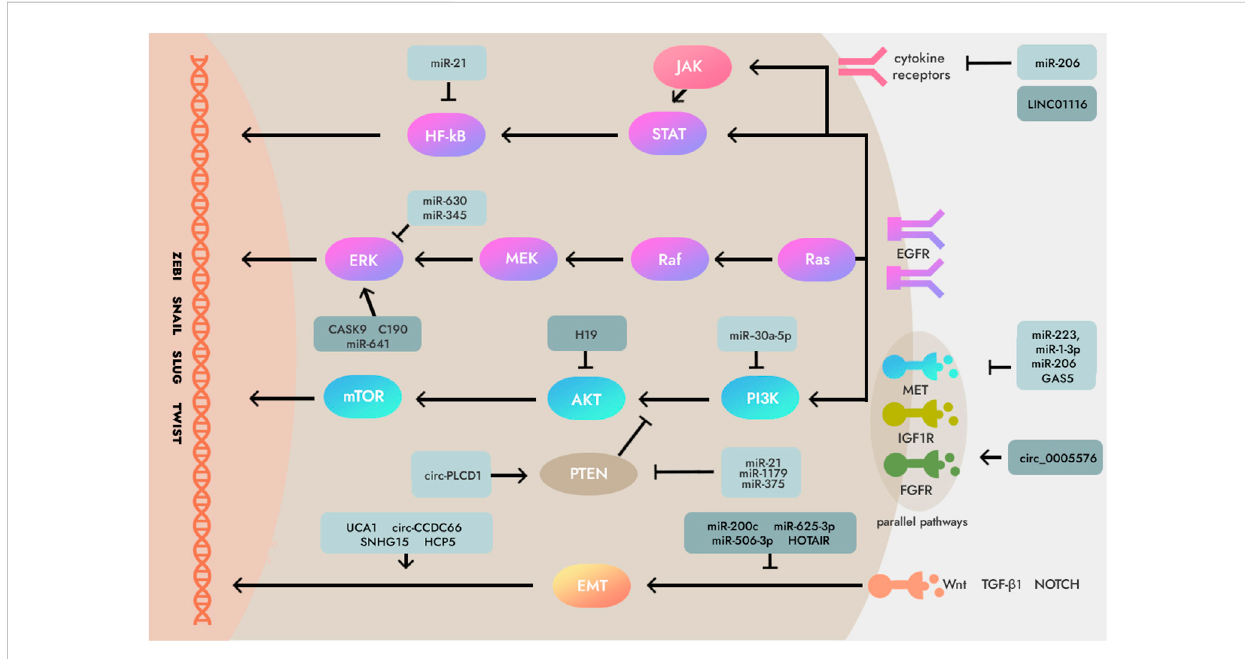
FIGURE 2 Mechanisms of non-coding RNAs (ncRNAs) which involved in essential signaling pathways downstream and parallel pathways of epidermal growth factor receptor (EGFR) in some human cancers including gastric cancer (GC). Several critical ncRNAs can regulate EGFR signaling pathways like Ras/Raf/ MEK/ERK axis, PI3K/AKT/mTOR axis, JAK/STAT/NF- κ B, PTEN, and Wnt/TGF- β 1/NOTCH. Note: MEK, Mitogen-activated protein kinase; ERK, Extracellular signal-regulated kinase; PI3K, Phosphoinositide 3-kinases; AKT, Serine/threonine-protein kinase; mTOR, Mammalian target of rapamycin; JAK, Januskinasetwo;STAT,Signaltransducerandactivatoroftranscription;NF- κ B,Nuclearfactorkappa-light-chain-enhancerofactivatedBcells;NOTCH, Neurogenic locus notch homolog protein; EMT, epithelial-mesenchymal transition; IGF1R, Insulin-likegrowth factor 1 receptor;PTEN,Phosphatase and ten sin homolog deleted on chromosome 10; TGF- β 1, Transforming growth factor- β 1; FGFR, Fibroblast growth factor